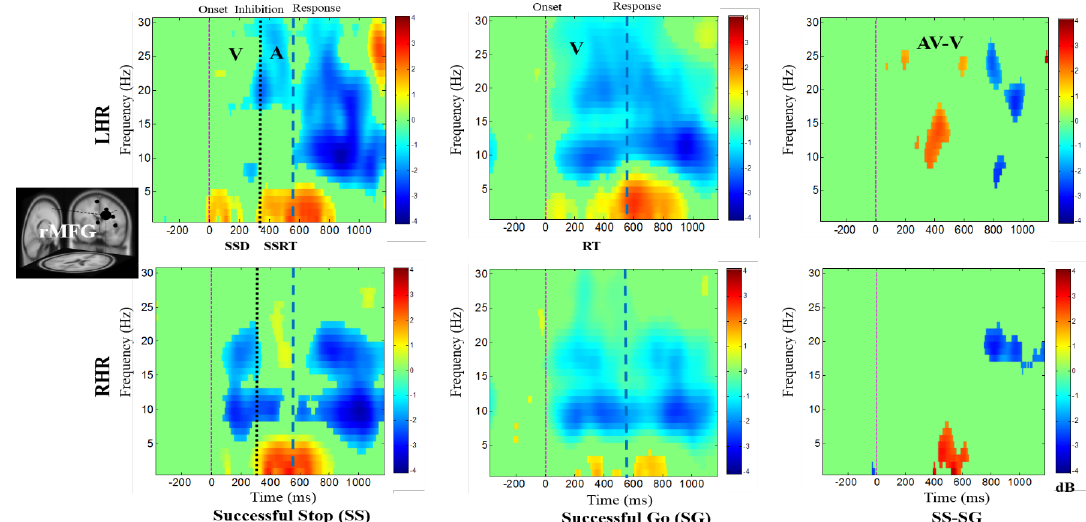
Figure 4. The event-related spectral perturbation (ERSP) plots showing the post-stimuli EEG modulations in right middle frontal gyrus (rMFG) of the brain under combined visual (V) stimuli and auditory (A) alarms. The successful go (SG) trial is elicited by only visual stimuli, and the successful stop (SS) trial is elicited by auditory alarms. In (SS-SG) condition, the ERSP plots display the EEG modulation of auditory alarms by comparing the ERSP plots of audio-visual (AV) and visual V) stimuli; (AV-V). Purple dashed line: Onset of the visual stimuli. Black dashed line: Onset of the auditory alarms. Blue dashed line: Onset of response. Color bars show the amplitude of the ERSP; statistical threshold at p < 0.01.